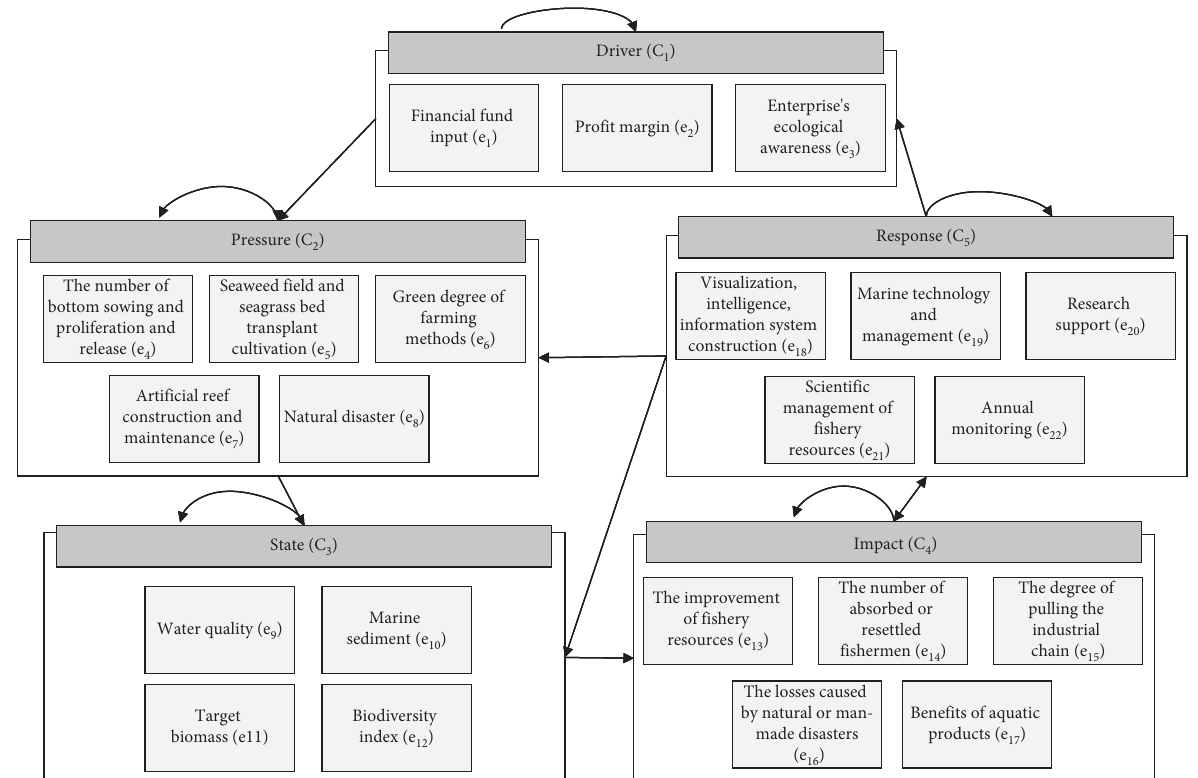
Figure 2: Network model of MRES